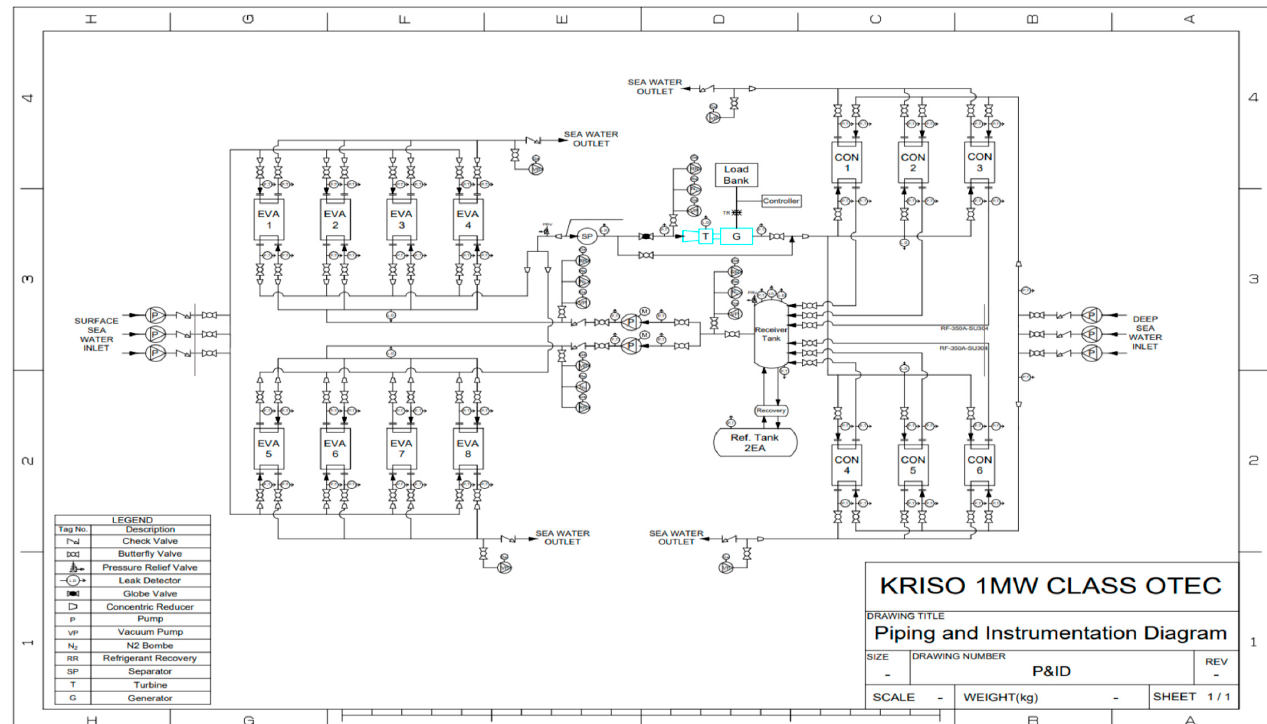
Figure 9. P&ID diagram for optimal seawater and refrigerant pump control.